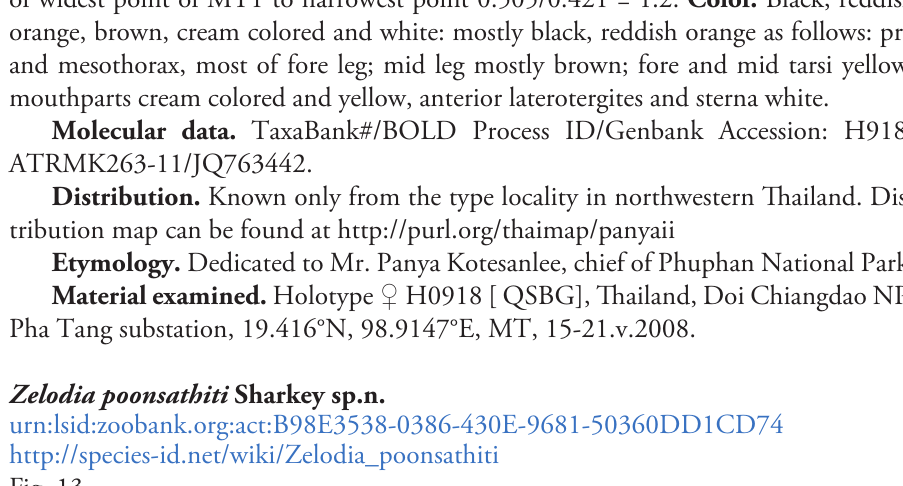
Diagnosis. Mesoscutum mostly melanic except margins pale; hind tibia all melanic. Description. Body length. 7.2 mm. Head. 39 flagellomeres. Median ocellus diameter equal to the space between lateral ocelli. Vertex sparsely and weakly punctate.